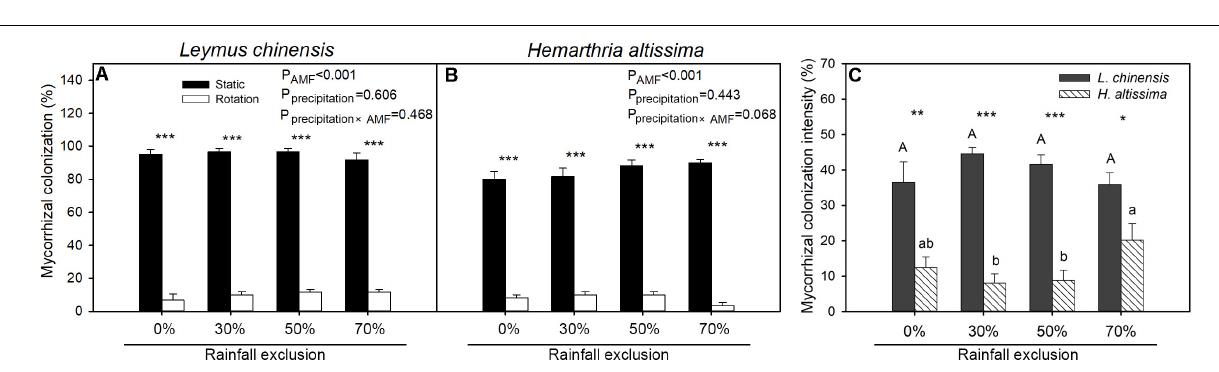
exclusion treatments, AMF meanly increased plant biomass of L. chinensis and H. altissima by 47% ( P = 0.003, Table 1 , and Supplementary Figure S2A ) and 37% ( P = 0.011, Table 1 ,